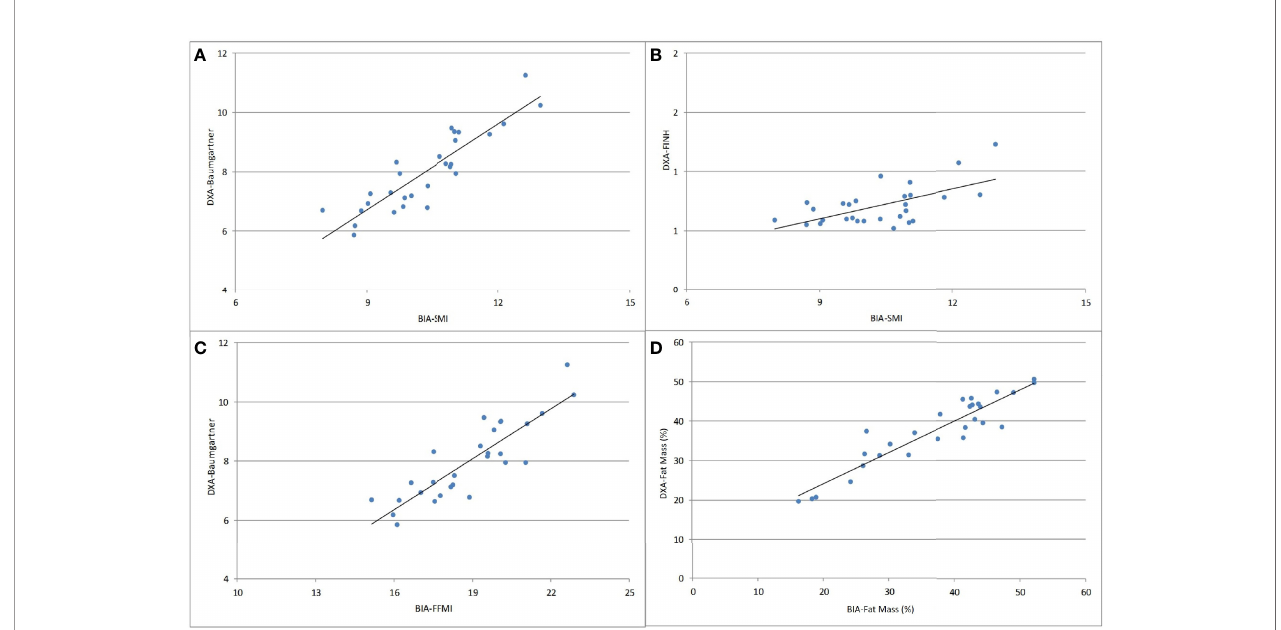
FIGURE 3 | Correlations between BIA and DXA parameters of body composition analysis. (A) SMI-BIA x Baumgartner-DXA (r=0.890, p<0.001); (B) SMI-BIA x FNIH-DXA (r = 0.498, p = 0.007); (C) FFMI-BIA x Baumgartner-DXA (r=0.868, p<0.001); (D) fat mass (%) BIA x fat mass (%) DXA (r=0.929, p<0.001). SMI, skeletal muscle mass index; Baumgartner, Baumgartner index; FNIH, Foundation for the National Institutes of Health; FFMI, fat-free mass